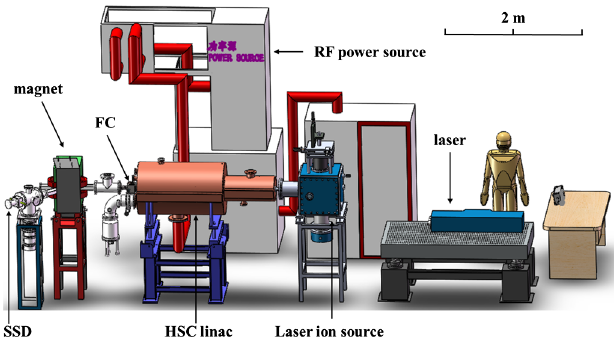
FIG. 13. The high power test system for HSC C 6 þ ion